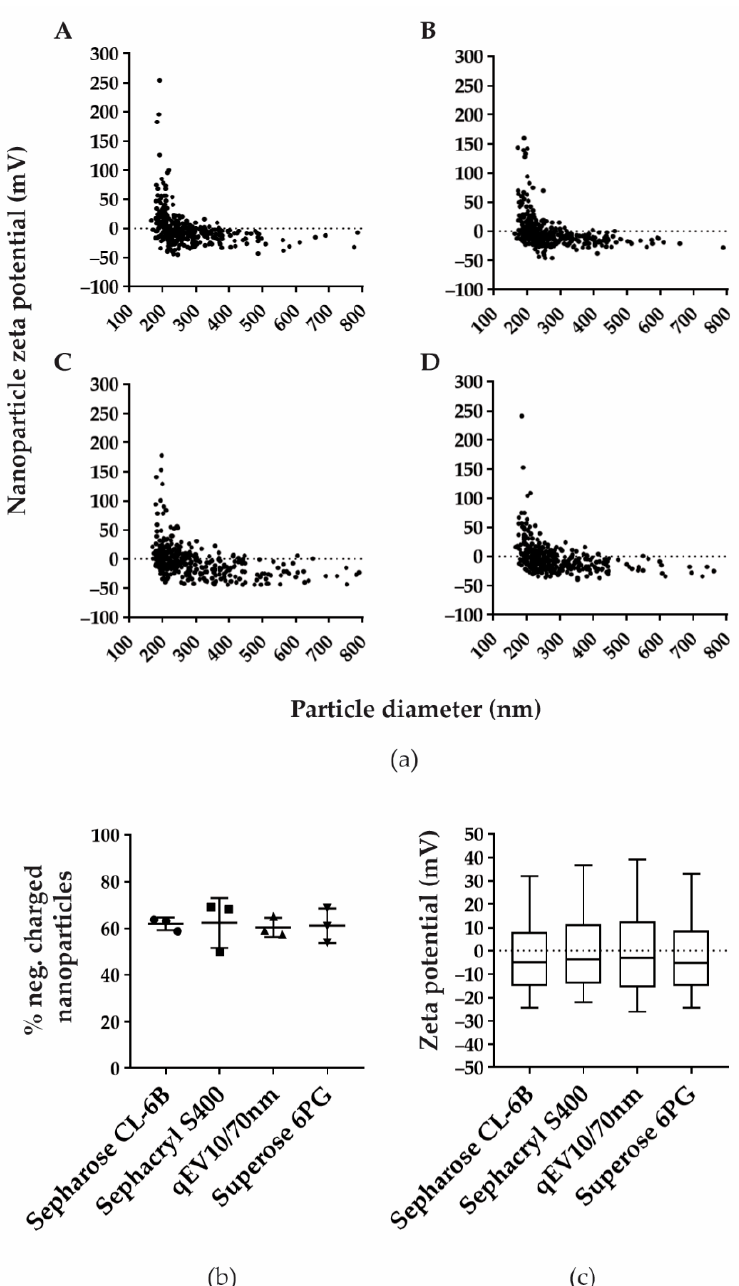
Figure 3. Zeta potential and percentage of negatively charged isolated nanoparticles are comparable in all four SEC methods. ( a ) Zeta potential was measured in TRPS positive fractions after separation by Sepharose CL-6B ( A ), Sephacryl S-400 ( B ), qEV10/70nm ( C ), and Superose 6PG ( D ). Shown are representative distributions of nanoparticle zeta potential measured in millivolts (mV) and nanoparticle diameter measured in nanometres (nm). ( b ) Percentage of negatively charged nanoparticles are shown as mean values with their standard deviation from three experiments for each SEC method. ( c ) Measured zeta potentials are presented as median values and interquartile ranges (boxes) coupled with 10–90 percentile ranges (whiskers).